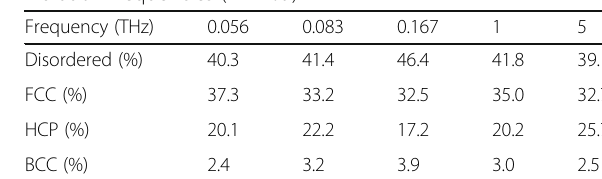
Table 5 Number fraction of atoms with different local crystalline orders in the products sintered under different